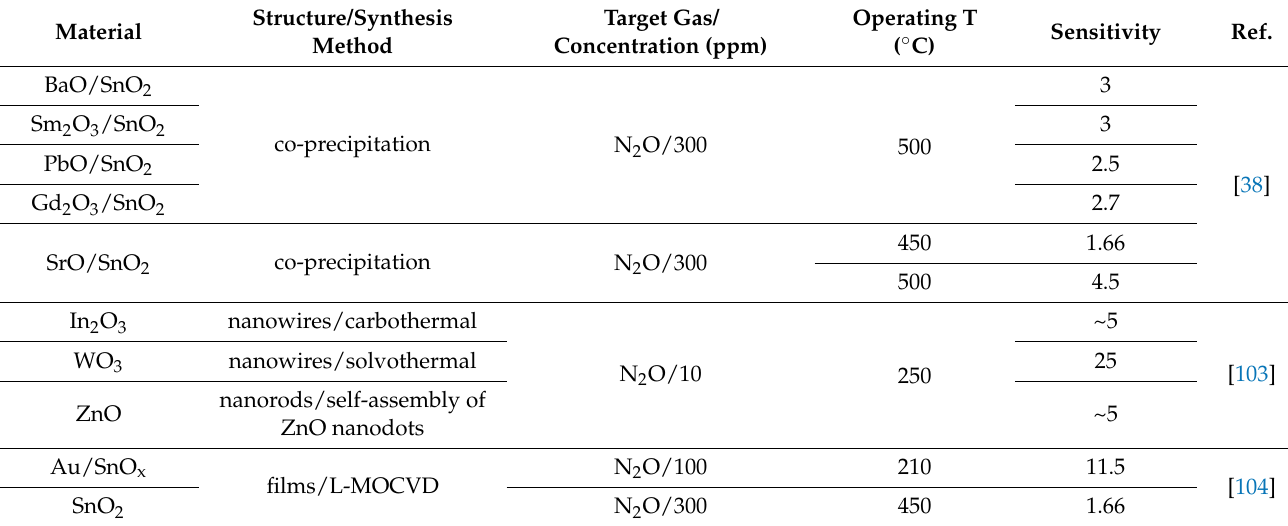
Table 6. Summary of MOX-based nitrous oxide gas